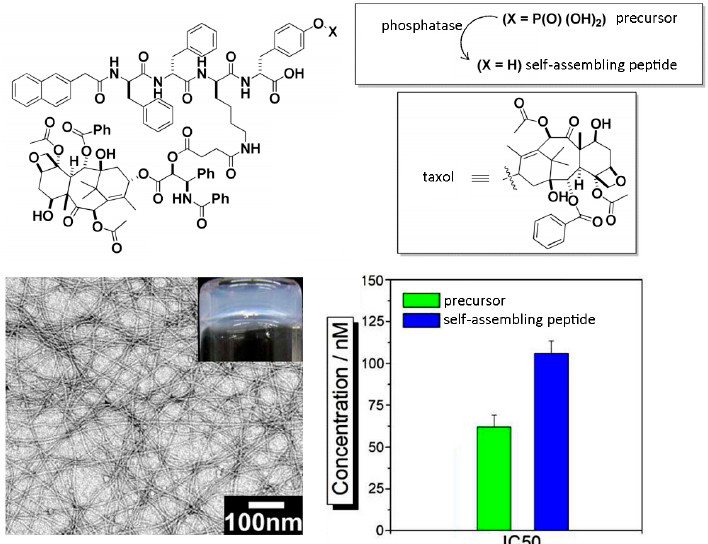
Figure 2. Chemical structure of a self-assembling peptide derivative covalently linked to taxol and formed upon phosphatase conversion of a phosphate precursor (top); upon self-assembly, a nanostructured hydrogel was formed and the IC 50 calculated (bottom). Adapted with permission from ref. [63] © 2013 American Chemical Society.